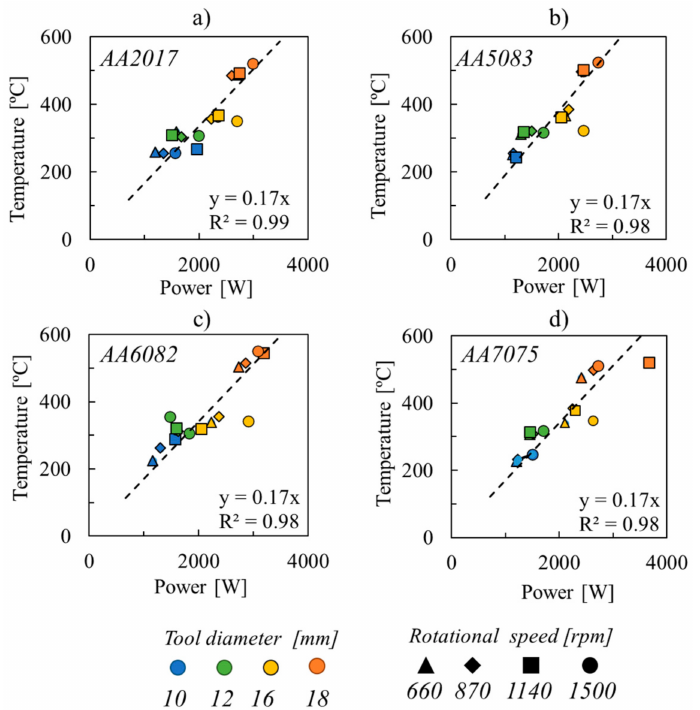
Figure 10. Evolution of temperature with the welding power, for the ( a ) AA2017, ( b ) AA5083, ( c ) AA6082 and ( d ) AA7075 aluminium